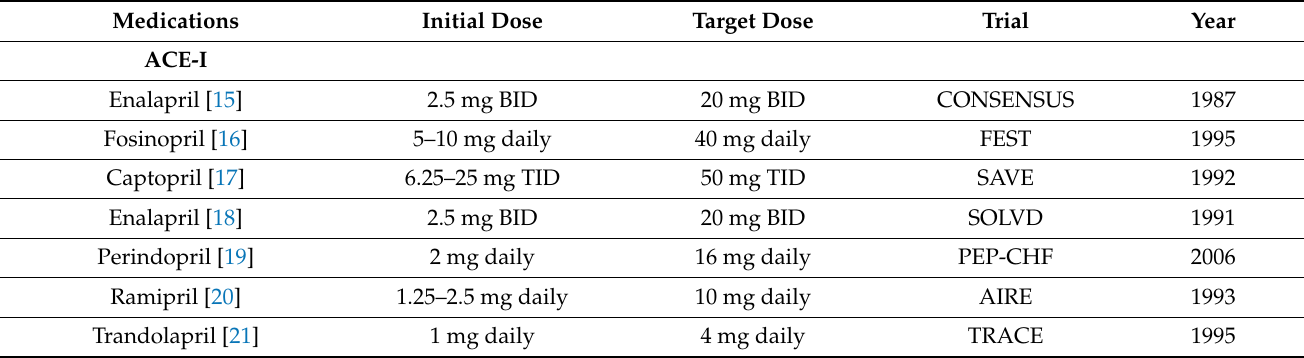
Table 1. Evidence of available pharmacological therapy of heart